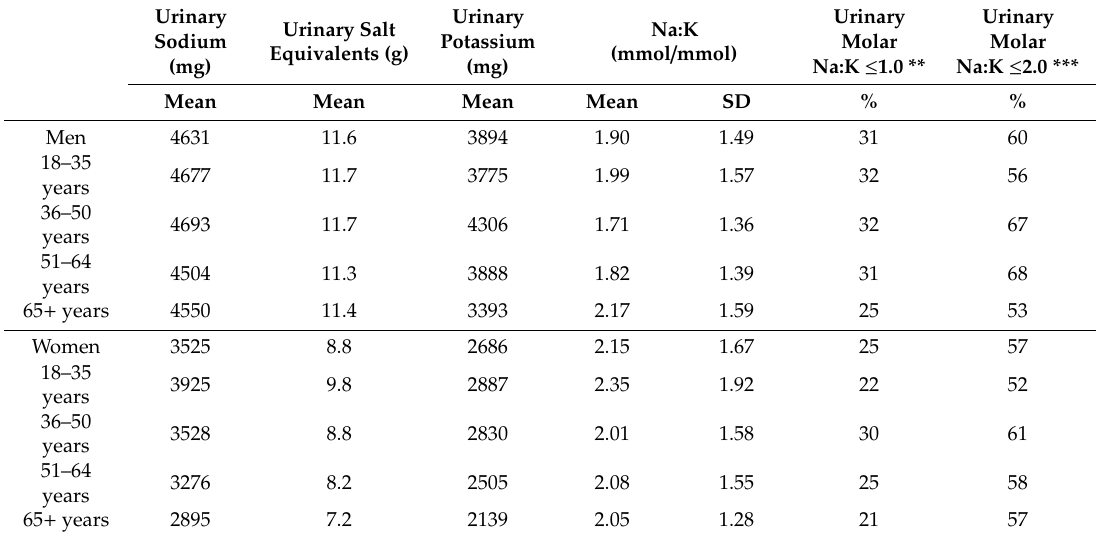
Table 1. The 24 h urinary excretions of sodium, salt and potassium.